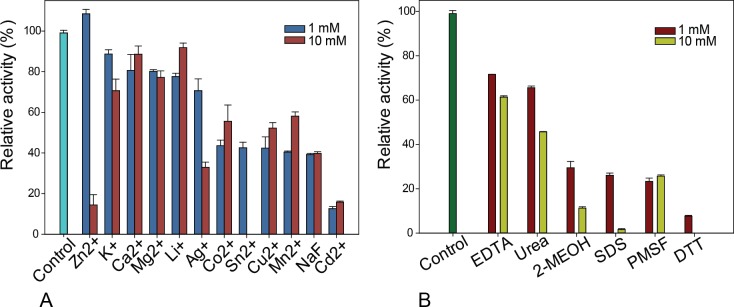
Effect of various metal ions, common inhibitors and denaturants on MZ0003 activity.A) Activity tested with addition of KCl, LiCl, AgCl2, NaF, ZnCl2, CaCl2, MgCl2, CoCl2, SnCl2, CuCl2, MnCl2 and CdCl2 at concentrations of 1 and 10 mM. B) Activity tested with: EDTA, Urea, 2-Mercaptoethanol (2-MeOH), SDS, PMSF and DTT at concentrations of 1 and 10 mM. MZ0003 was incubated with each chemical for 1 hour in 0.1 M TRIS HCl pH 8.0 on ice and then the activity was tested with p-NP acetate at 35°C. All data are the average of three independent experiments, error is the standard deviation.